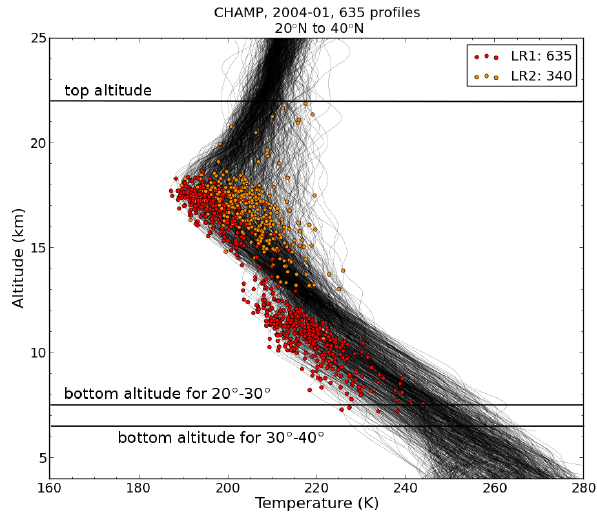
Figure 2. CHAMP temperature profiles and their tropopauses be- tween 20 and 40 ◦ N in January 2004. First tropopause: red; second tropopause: orange. Top and bottom altitudes of the tropopause al- gorithm are indicated by horizontal lines.